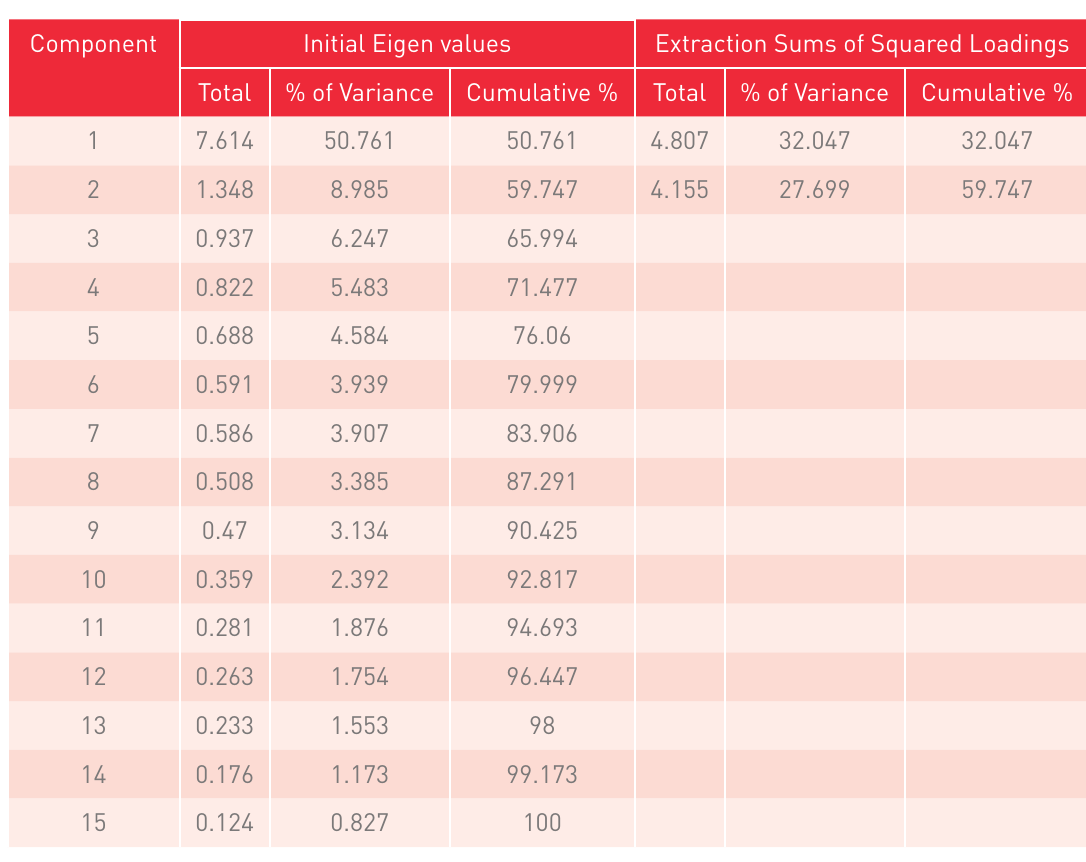
3D printing Awareness of Total Variance Explained Component